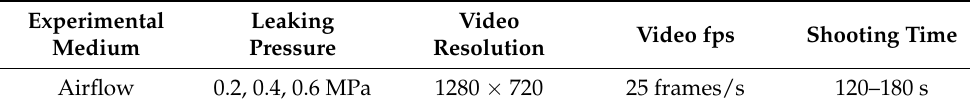
Table 1. Experimental configuration for the underwater gas leak.